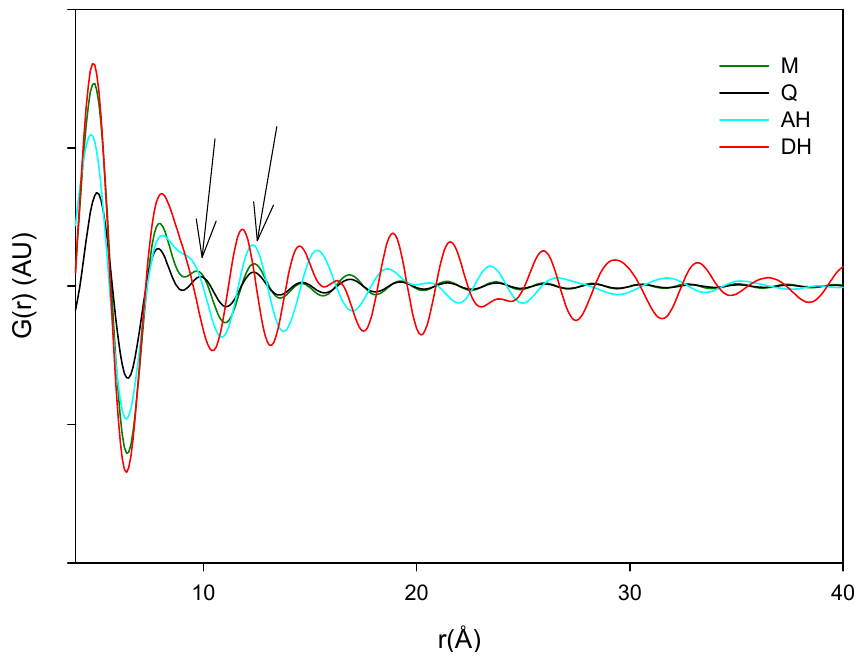
Figure 9. Averaged raw PDF traces of crystalline anhydrate (AH), crystalline dihydrate (DH), milled (M) and quench cooled (Q) samples.